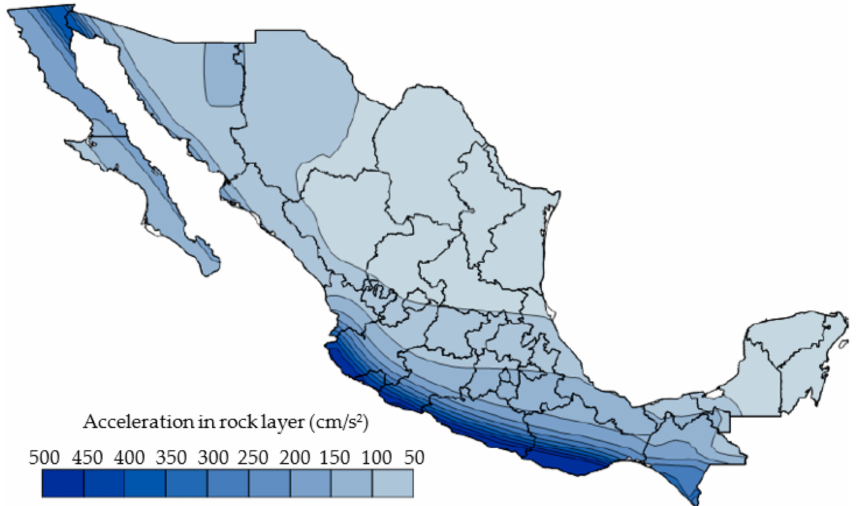
Figure 1. Maximum acceleration in the rock layer used for the reference spectrum ER, reproduced with permission from Ulises Mena, Comisi ó n Federal de Electricidad Manual de Diseño de Obras Civiles; published by Comision Federal de Electricidad (CFE), 2015 [1].